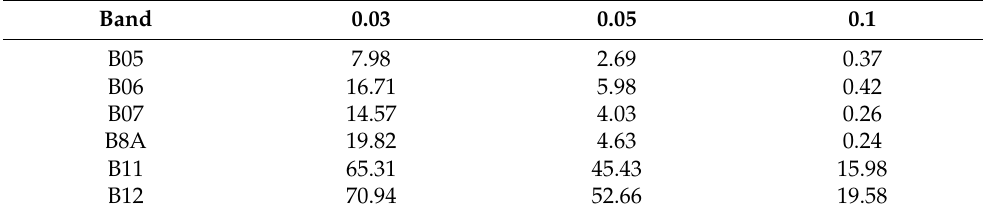
Table 10. Percentage of pixels beyond a given relative error threshold for reflectances in [0.25, 0.5] (L1C).